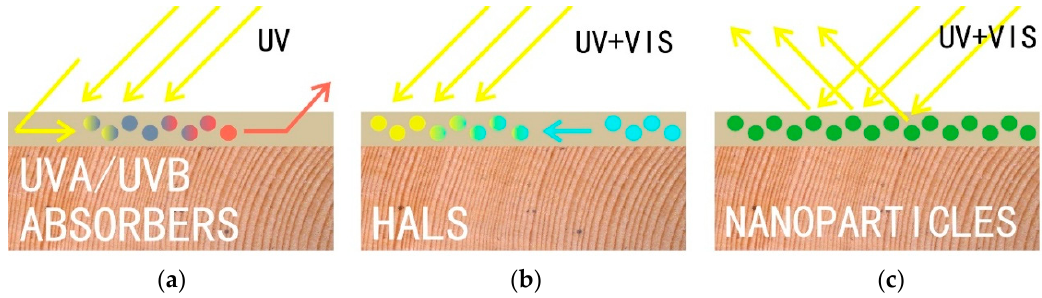
Figure 1. Schematic representation of the principle of the effect of UV-absorbers ( a ) HALS ( b ) and nanoparticles ( c ) for reducing the degradation effect of solar radiation on surface layers of wood. ( a ) Radiation absorbed and converted into heat energy by UV absorbers [25,28,33,47]; ( b ) Harmful free radicals absorbed and neutralized by HALS [26,42]; ( c ) Radiation reflected and scattered by nanoparticles [27,33,45,48].